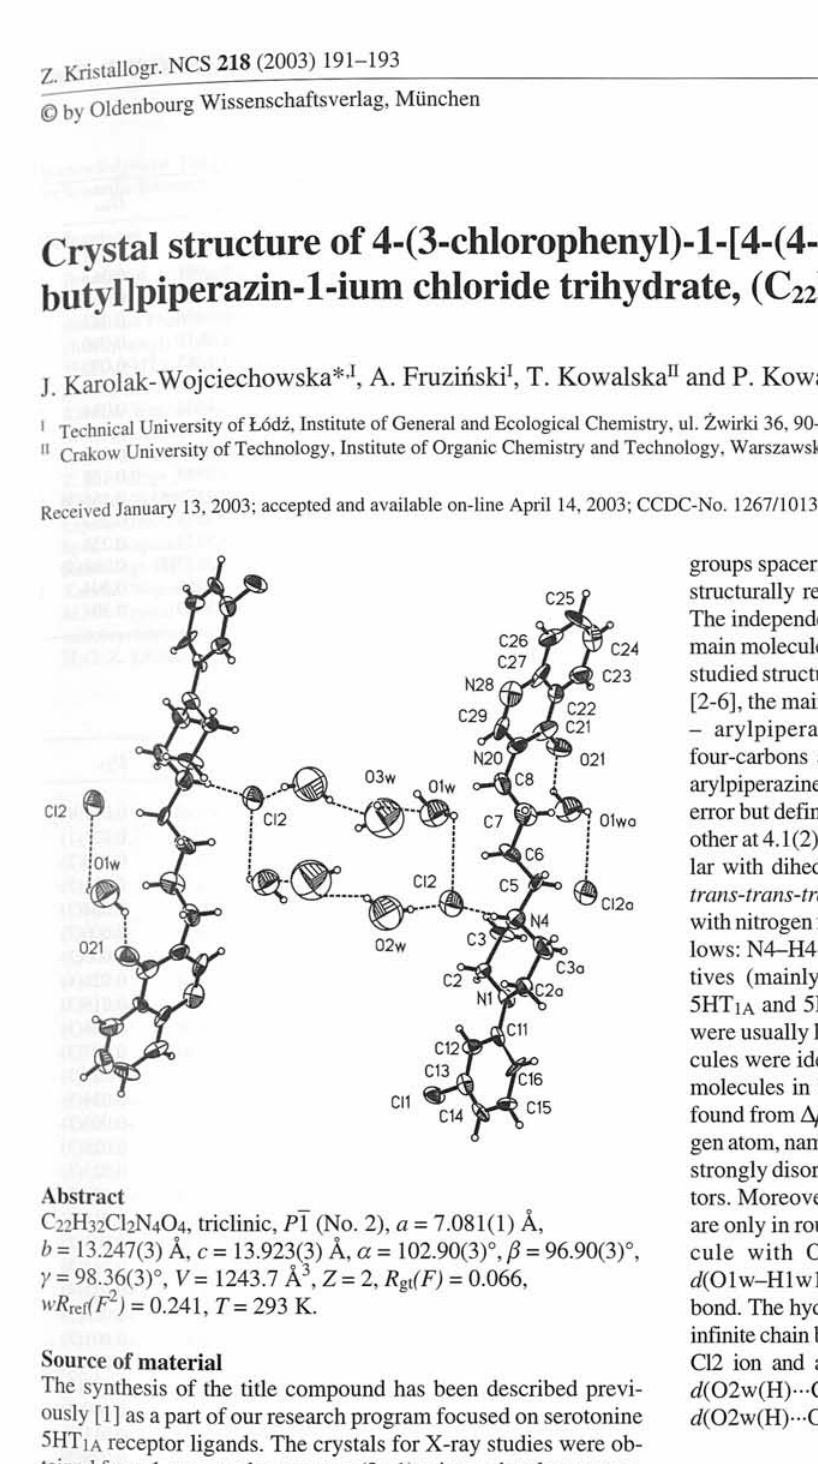
Table 1. Data collection and